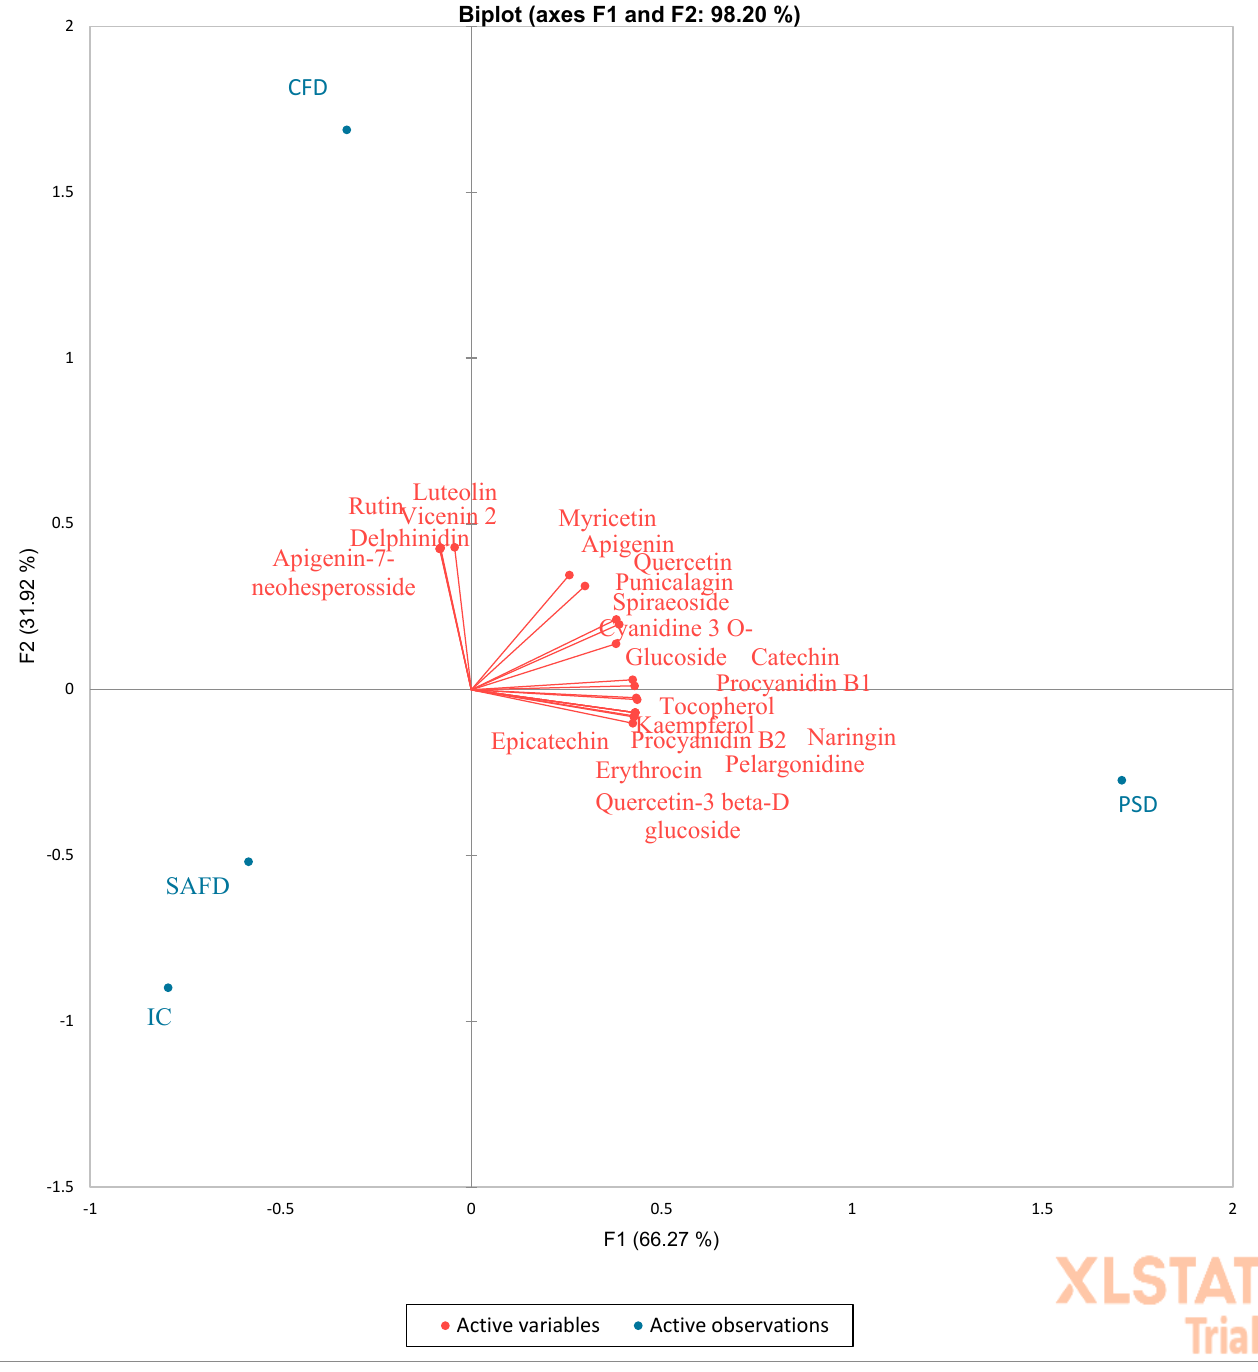
Figure 6. PCA (principal component analysis) diagram of single flavonoids contained in the peels of different pomegranate cultivars dried differently. PSD (spray-dried Wonderful peel, experimental data); CFD (Calabrian Wonderful peel freeze-dried, experimental data); SAFD (South African Wonderful peel freeze-dried, literature data); IC (Indian cultivar peel freeze-dried, literature data).